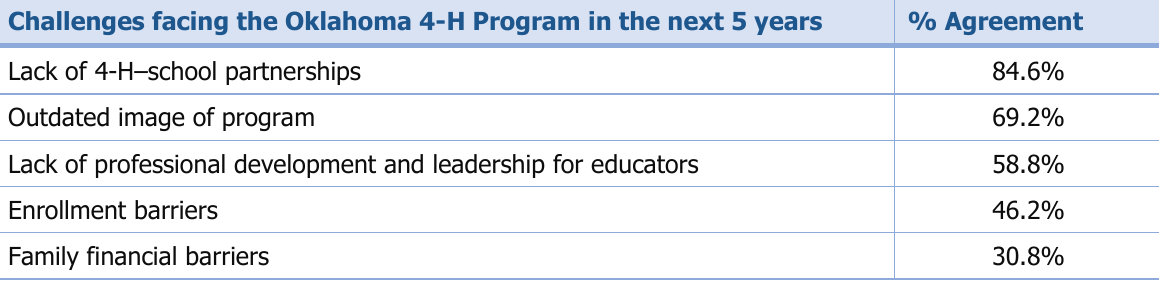
Table 4. Challenge Statements and Agreement Percentages in Round 3: Panel 2 Challenges facing the Oklahoma 4-H Program in the next 5 years